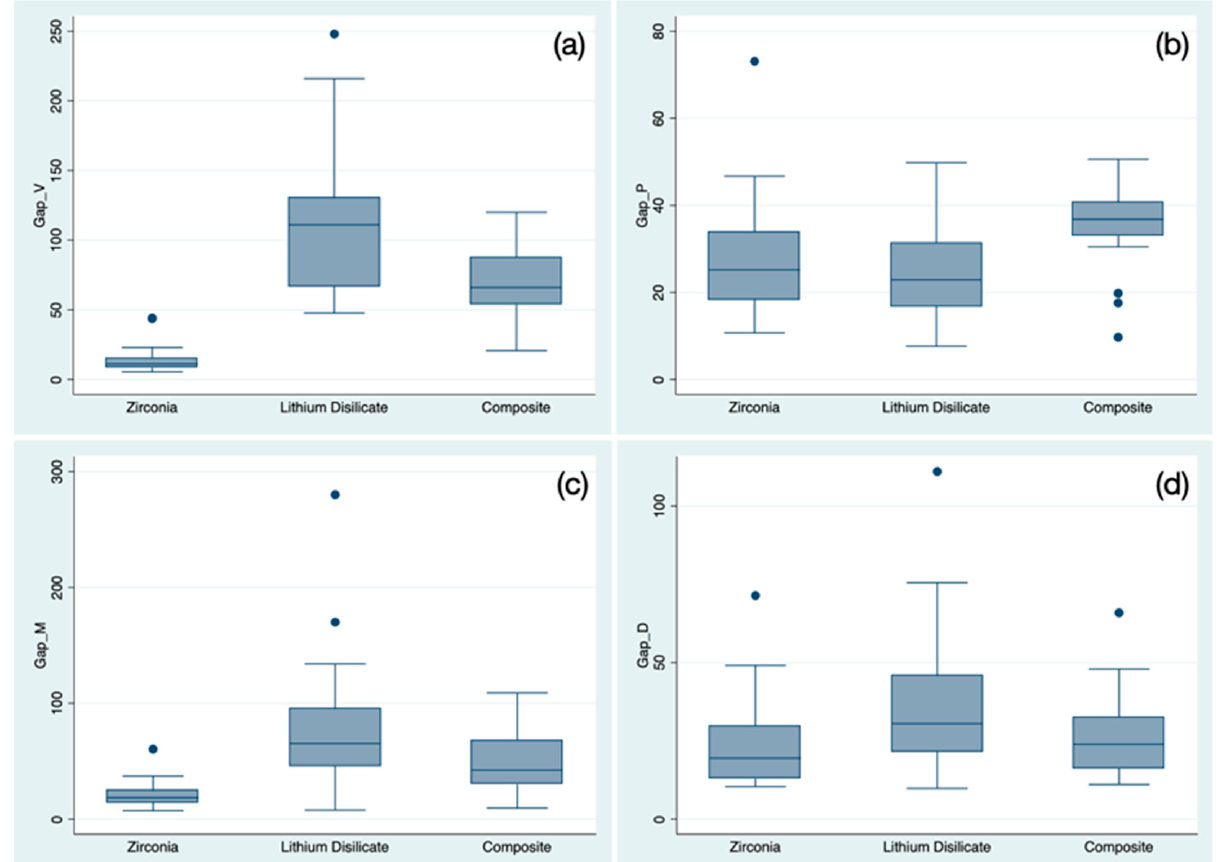
Figure 8. Boxplot representing the sample distribution according to the gap’s location: ( a ) vestibular gap; ( b ) palatal gap; ( c ) mesial gap; and ( d ) distal gap. Outlier values are indicated by “ • ” symbols.